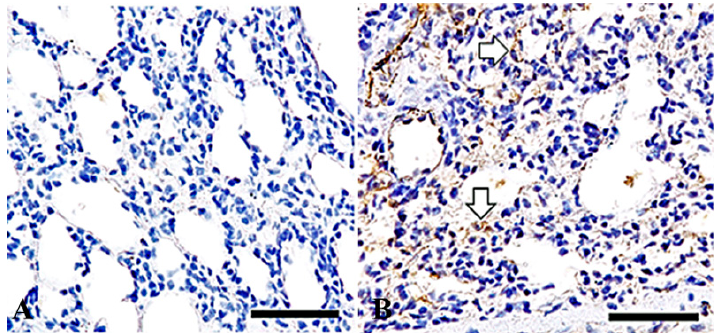
Figure 5. Alpha-SMA immunohistochemistory in the lungs of mice treated with 50 mg/m 3 of the powder for one day ( A ) and treated for 15 days ( B ). Spindle-shaped to elongated cells in the inflammatory lesions show positive immunolabelings for α -smooth muscle actin (( B ), white arrows). Bars = 50 µm.